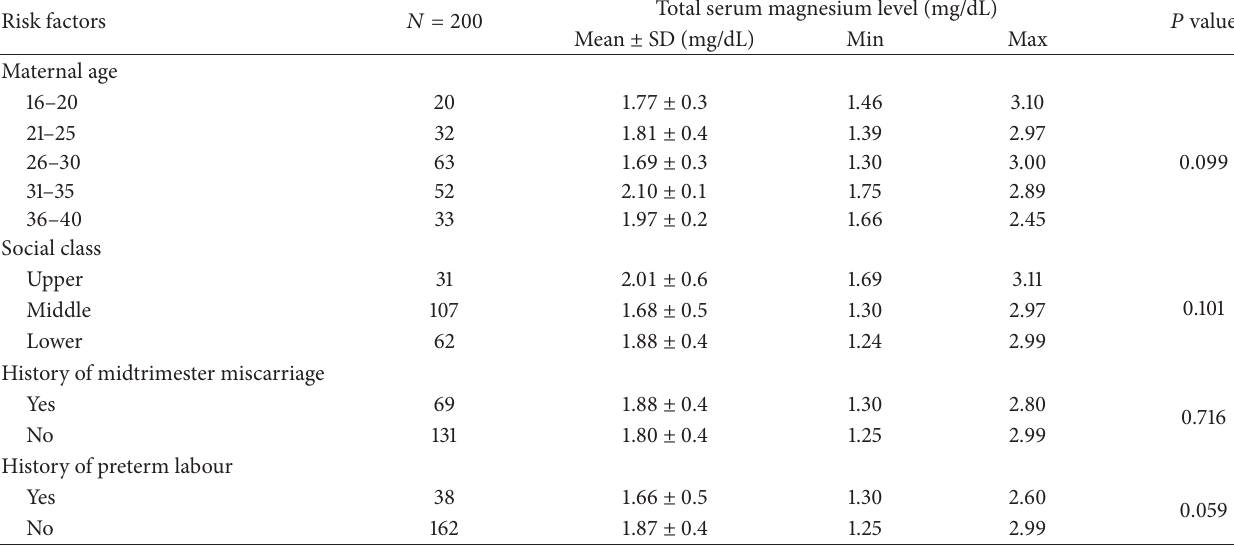
Table 6: Relationship between serum magnesium and the major risk factors for preterm labour. Risk